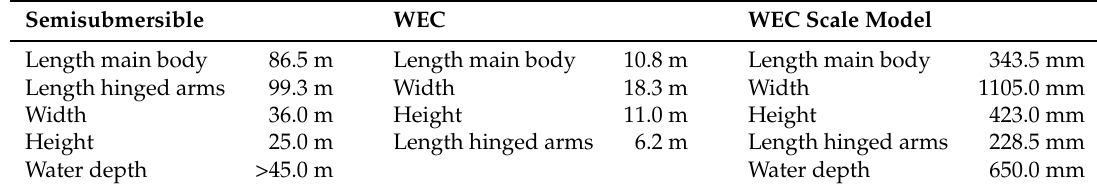
Table 1. Main dimensions of FPP conceptual design and model scaled WEC.